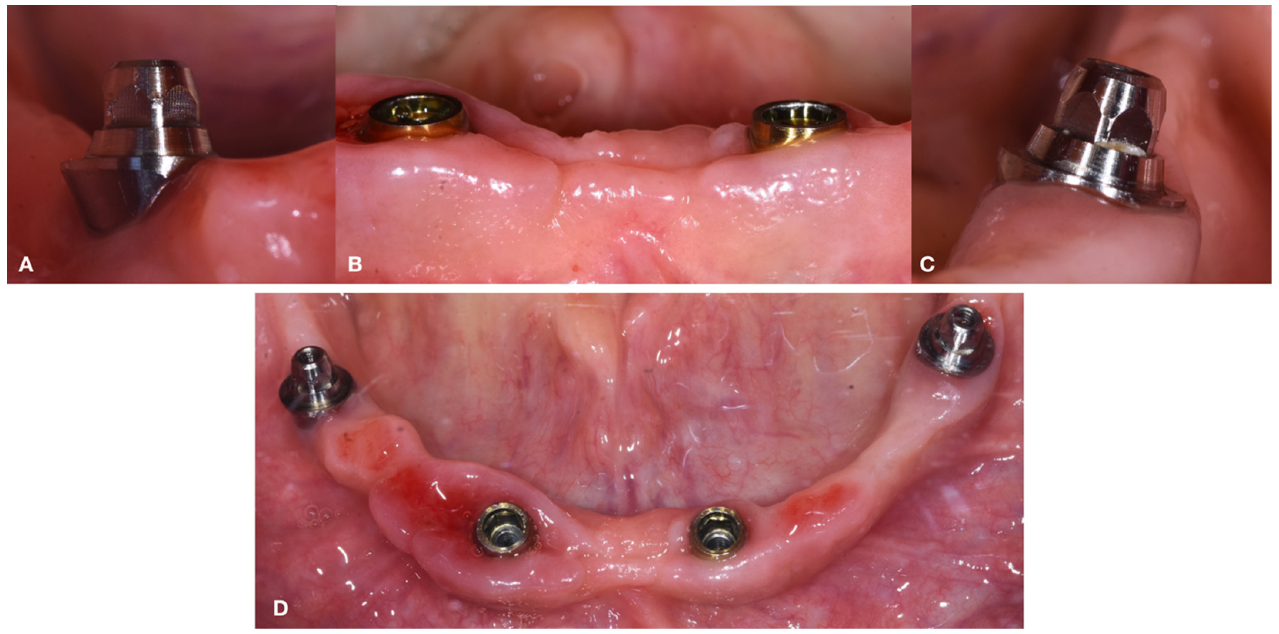
Figure 11. Implant X-rays immediately after load. (March 2022). Details of soft-tissue healing at 24 months are shown in Figure 12.